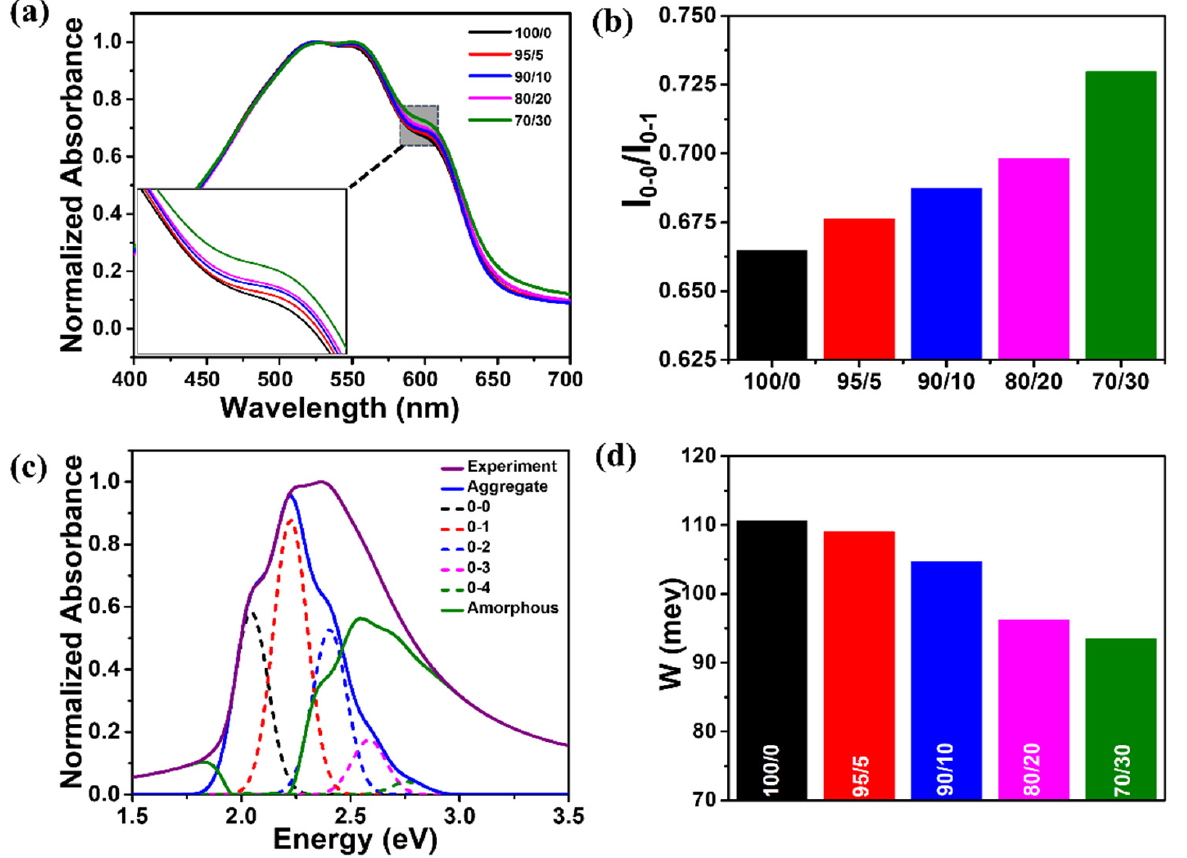
Figure 4. ( a ) Normalized UV-Vis absorption spectra of P3HT/g-C ₃ N ₄ composite films according to g-C ₃ N ₄ content (0, 5, 10, 20, and 30 wt.%). ( b ) Intensity ratios of (0-0) and (0-1) transitions of the corresponding composite films. ( c ) Absorption spectrum of P3HT/g-C ₃ N ₄ (90/10) composite film de- convoluted by Spano analysis using Equation (1). The green line indicates the spectrum of amor- phous P3HT chains, and the blue solid line depicts the spectrum of the P3HT aggregates in the film. ( d ) Calculated exciton bandwidth (W) of the P3HT/g-C ₃ N ₄ composite films with different g-C ₃ N ₄ contents.